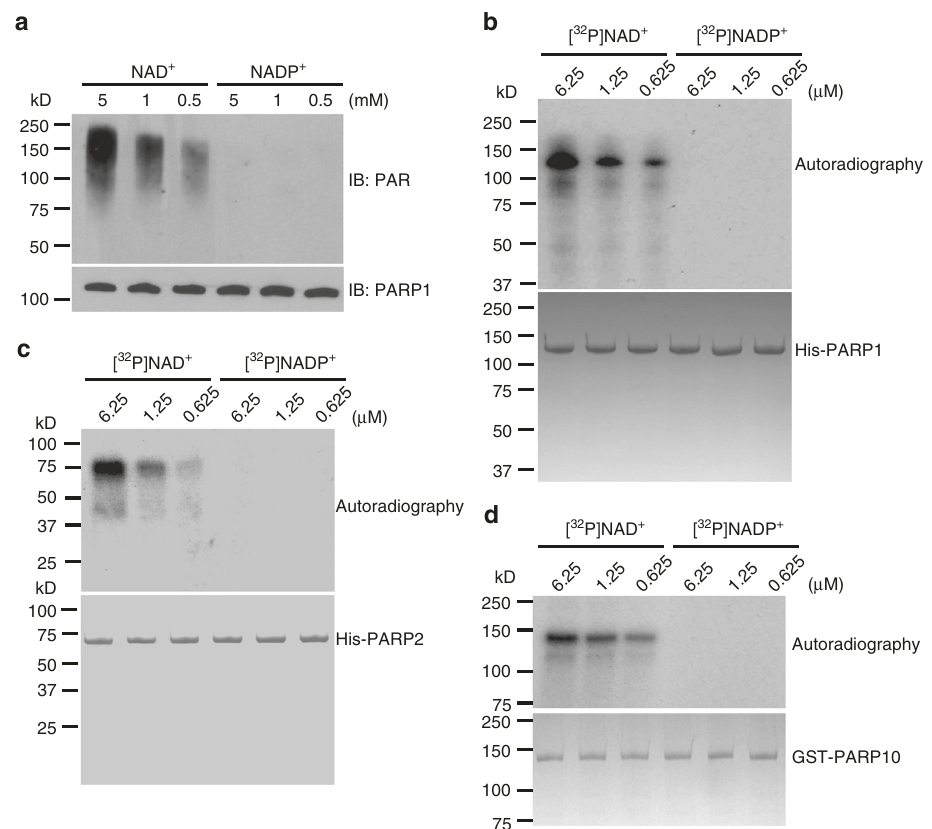
Fig. 2 NADP + is not a donor for poly(ADP-ribose) polymerase (PARP)-mediated ADP-ribosylation. a , b PARP1 cannot use NADP + for PARylation. PARP1- mediated in vitro PARylation assays were performed including recombinant HIS-PARP1, ssDNA, NAD + , or NADP + . Auto-PARylation of PARP1 was examined by western blotting. 5% of recombinant PARP1 in each sample was extracted before the reaction and was examined as the loading control ( a ). [ 32 P]NAD + or [ 32 P]NADP + was included in the in vitro PARylation assay. Auto-PARylation of PARP1 was examined by autoradiography ( b ). Coomassie staining of HIS-PARP1 was shown as the loading control. c NADP + cannot serve as the donor for PARP2-mediated PARylation. The in vitro PARylation was performed using recombinant HIS-PARP2, ssDNA, and [ 32 P]NAD + or [ 32 P]NADP + . Auto-PARylation of PARP2 was examined by autoradiography. Coomassie staining of HIS-PARP2 was shown as the loading control. d NADP + cannot serve as the donor for PARP10-mediated MARylation. Auto- MARylation of PARP10 was examined by autoradiography. Coomassie staining of GST-PARP10 was shown as the loading